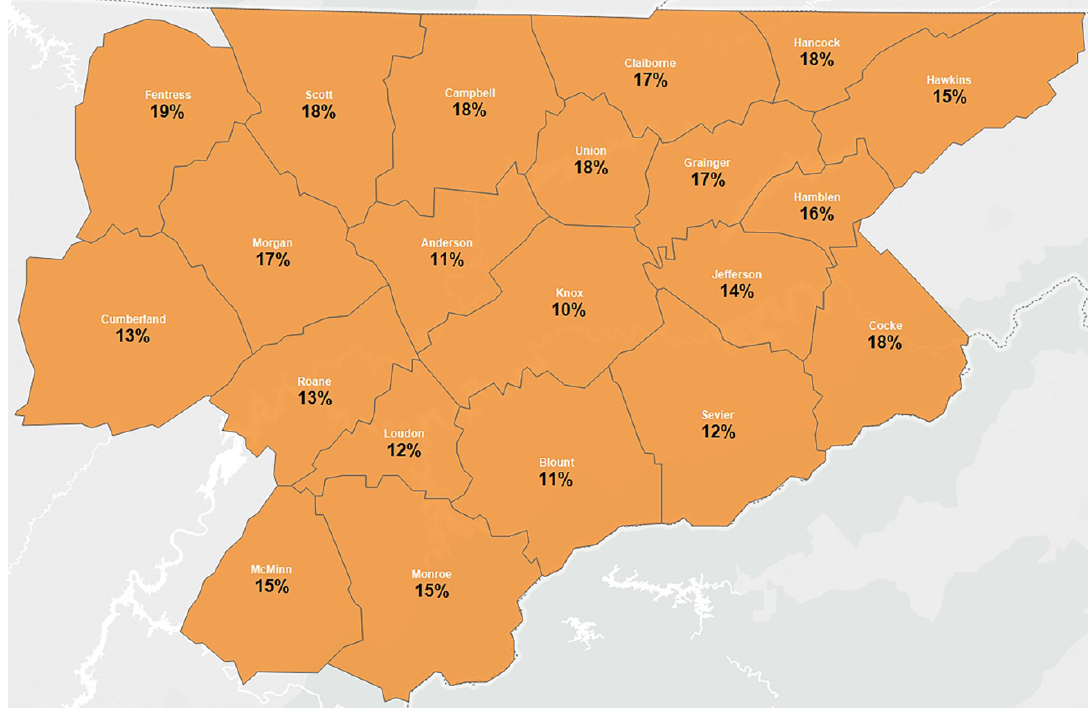
Figure 1 Counties served by University of Tennessee Medical Center and percentage of the population who lack basic prose literacy